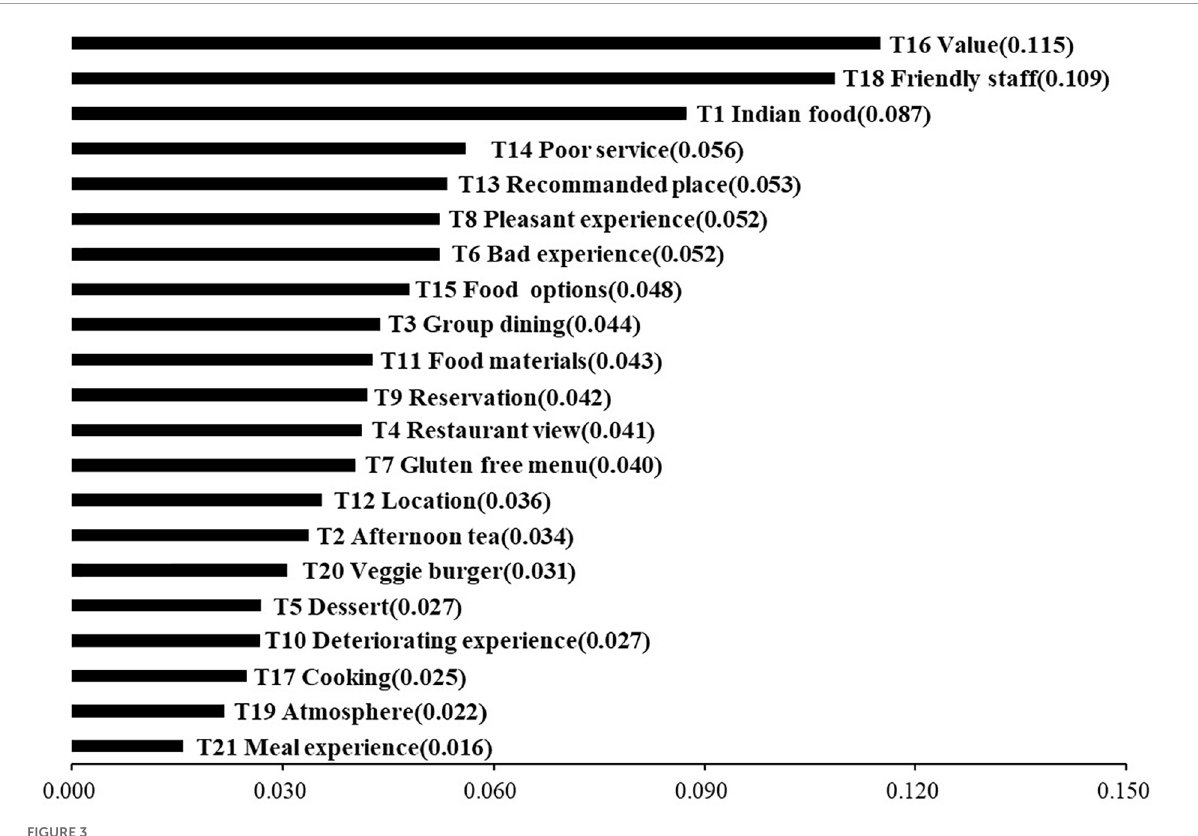
FIGURE3 A total of 21 identified topics by